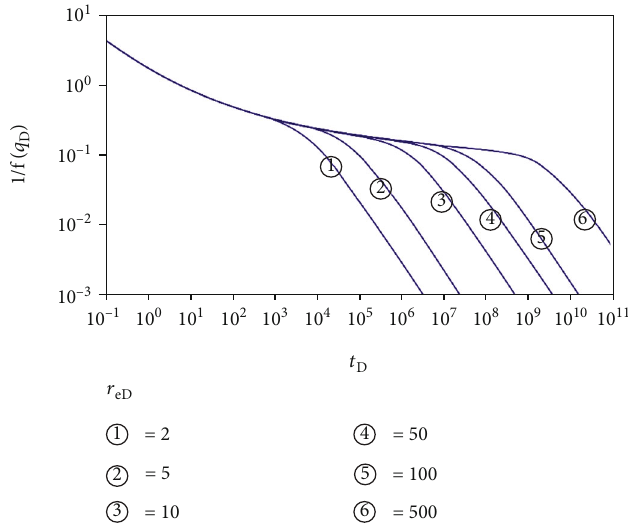
Þ vs. t D for a homogenous reservoir. D